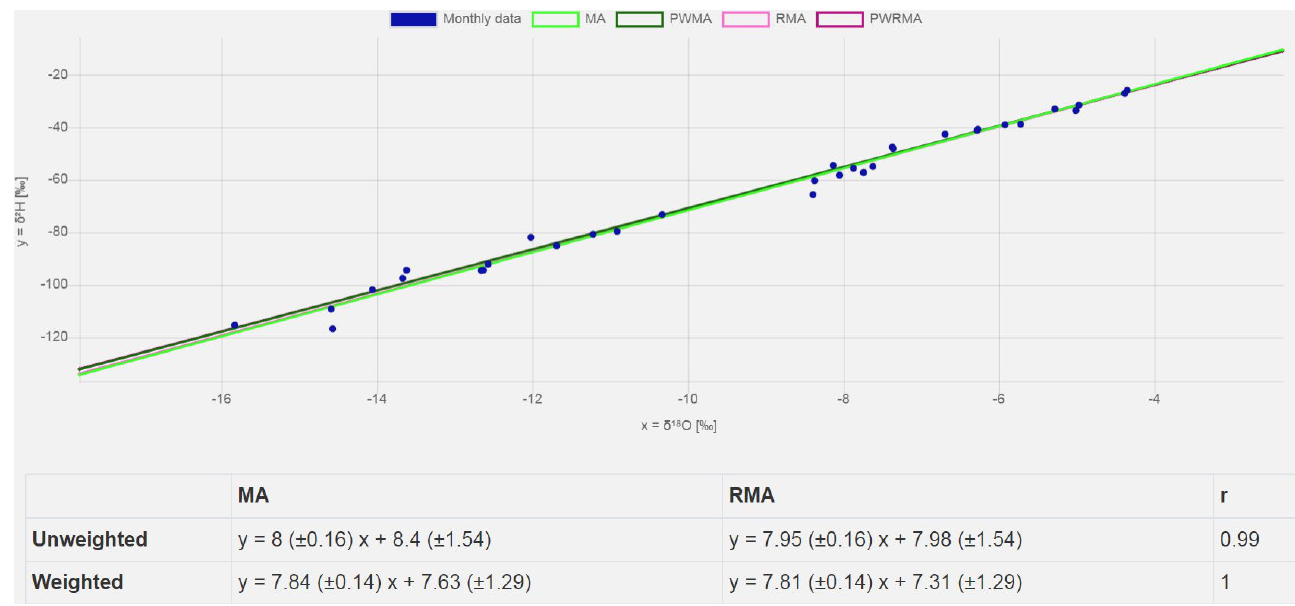
Figure 4. The snapshot of the scatter plot of δ 2 H versus δ 18 O including all monthly data (blue dots) and different LMWLs, i.e., precipitation-amount unweighted or weighted major axis (MA) or reduced major axis (RMA) regression lines for the Murska Sobota station data [52].